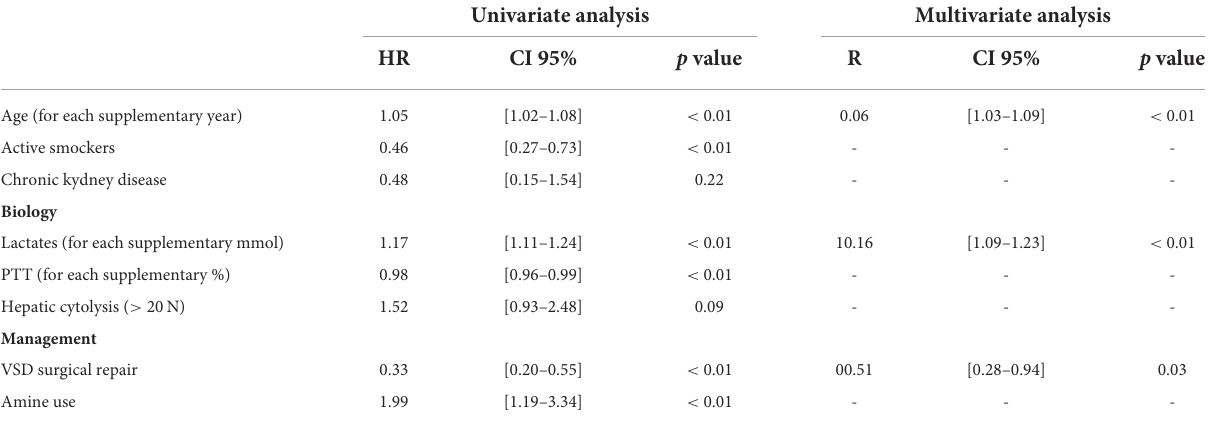
TABLE 3 Factors associated with 1-year mortality by Cox regression